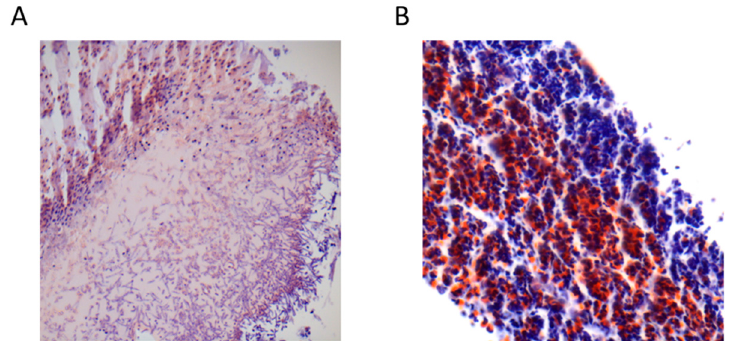
Figure 2. Images from Congo red staining. ( A ) Eosinophils, FEGs and FH (sample obtained by the aspiration of nasal secretions technique, 100× magnification); ( B ) Eosinophils, focal neutrophils, and FEGs (sample obtained by the nasal blown secretions technique, 200× magnification).